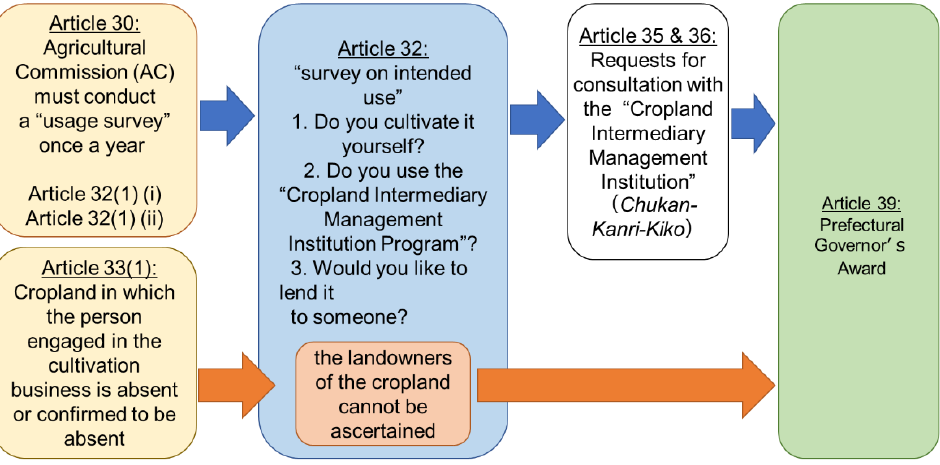
Figure 3. Measures in managing abandoned croplands [18].